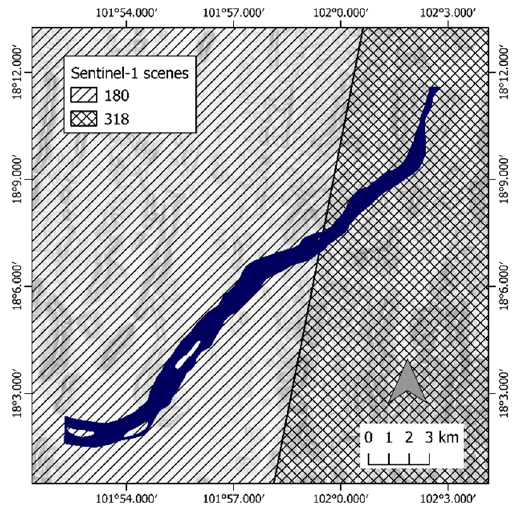
Figure 3. Number of Sentinel-1 images covering the study area for the period from January 2015 to December 2018.